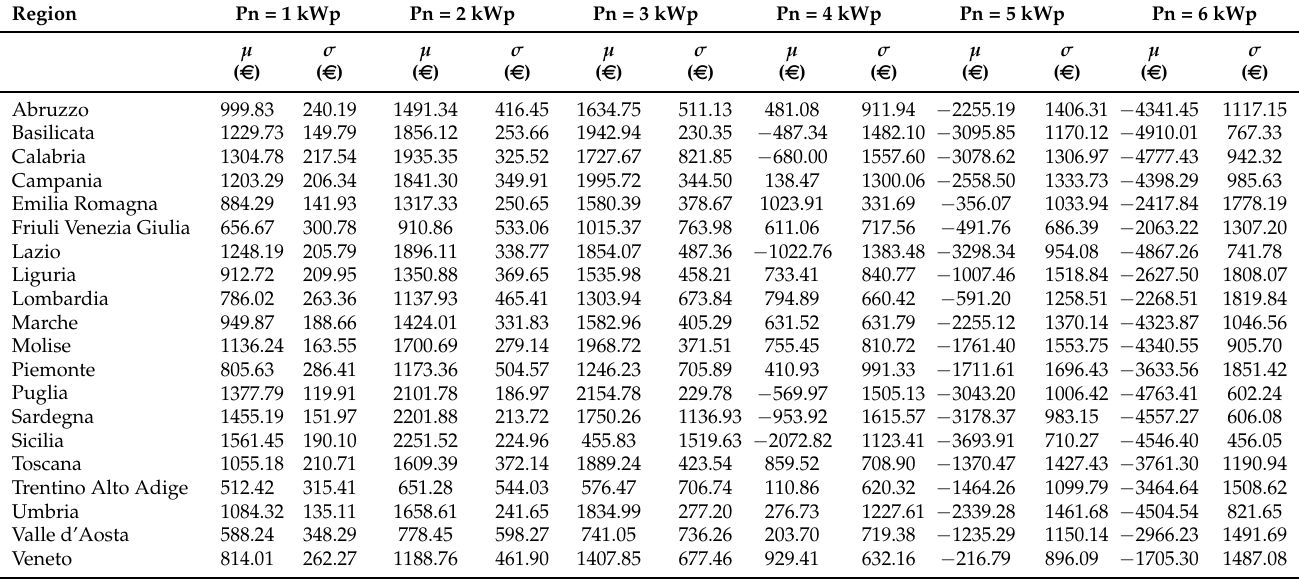
Table 29. NPV for E L = 4000 kWh with